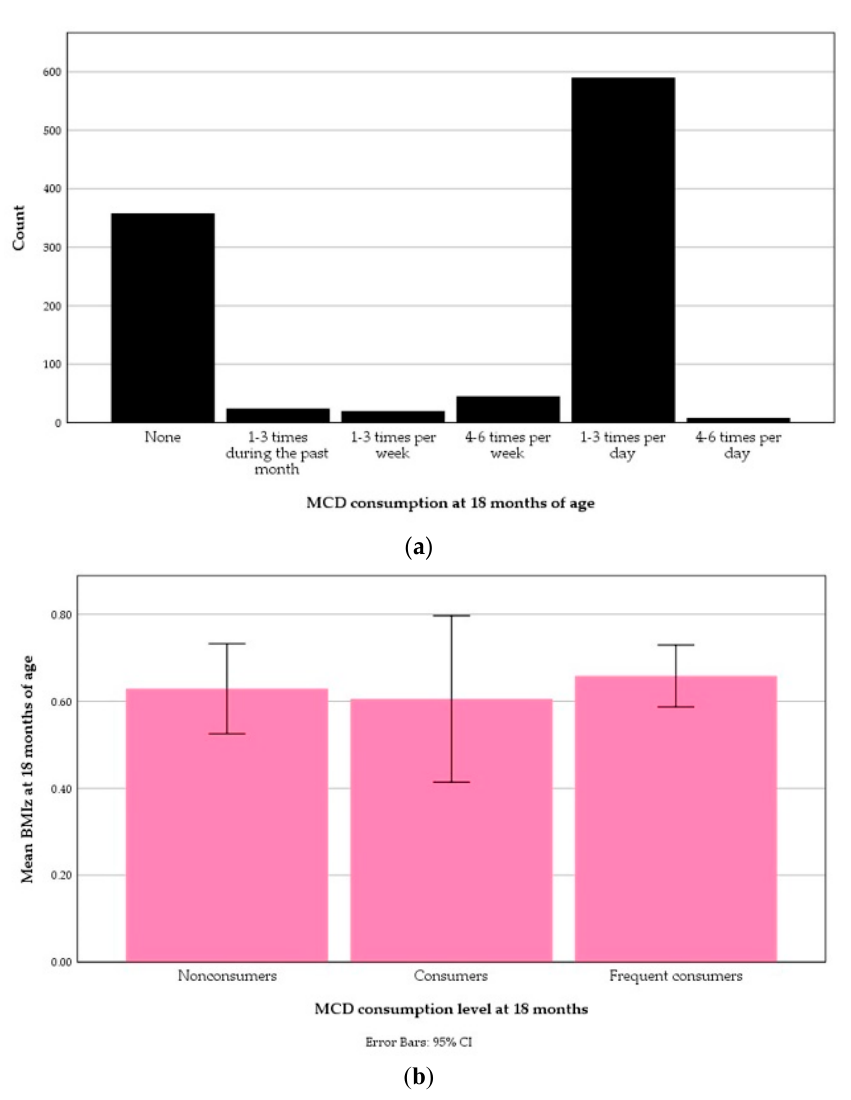
Figure 10. Milk cereal drink (MCD) consumption at 18 months of age: ( a ) Distribution; ( b ) An error bar of distribution in relation to body-mass index z -score (BMIz) at 18 months.